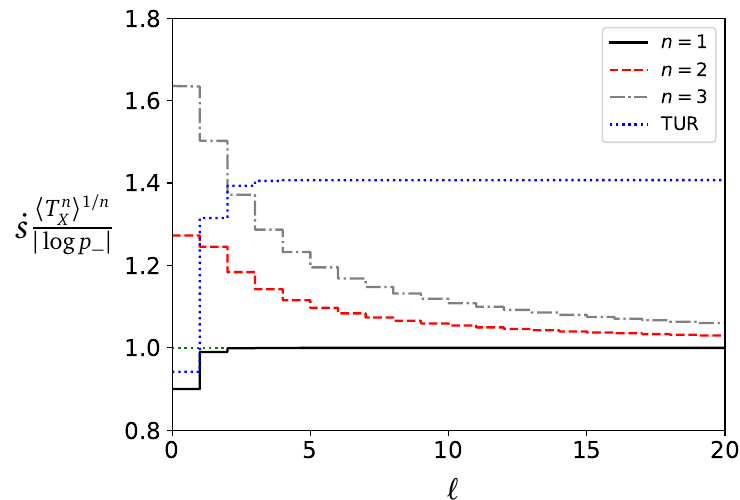
Figure 5: Comparing the tightness of the first-passage time bounds Eq. (3) with the ther- modynamic uncertainty relation Eq. (59). The ratio ˙ s 〈 T n and the thermodynamic uncertainty (TUR) ratio ˙ s ( 〈 T 2 ted as a function of (cid:96) = (cid:96) − = (cid:96) + for a biased random walk process X described by Eq. (73) with k + = 1 and b = 0.1. Note that the inequalities Eq. (3) are tight for (cid:96) → ∞ , while the uncertainty relation Eq. (59) is